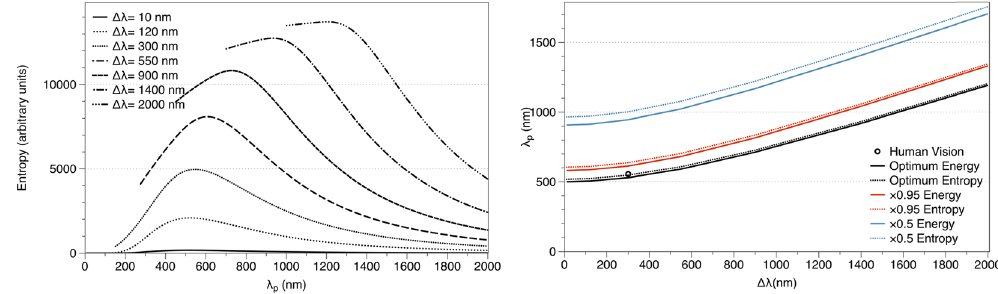
Figure 6. ( a ) (left): Entropy of solar radiation in the range λ p ± Δ λ for different values of Δ λ . ( b ) (right): Contours of equal solar intensity (continuous) and entropy